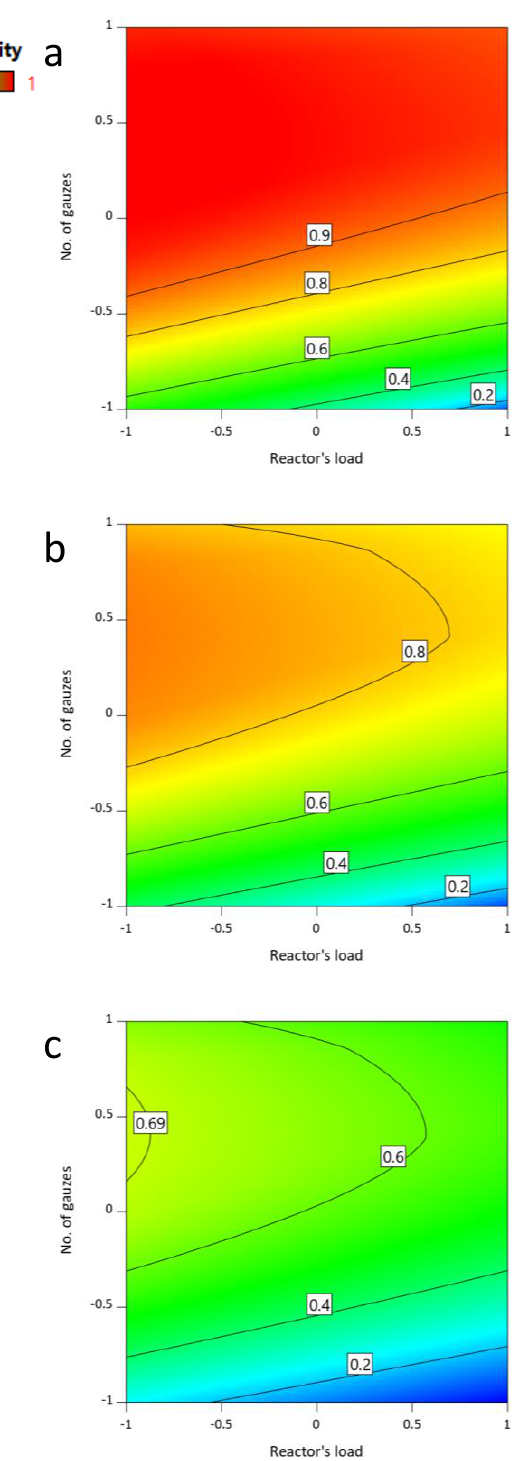
Figure 8. Desirability function plots. Effect of the reactor’s load ( X 1 ) and the number of catalytic gauzes ( X 3 ) at three levels of temperature ( a ) X 2 = −1 ; ( b ) X 2 = 0; ( c ) X 2 = 1.